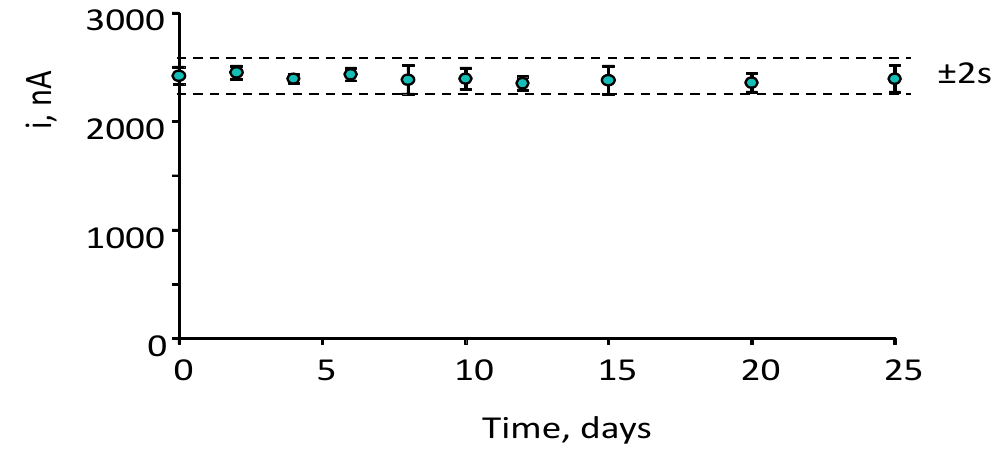
Figure 6. Control chart constructed to check the storage stability of anti–CCL5–Biotin–Neu–MBs conjugates upon storage at 8 ◦ C in Eppendorf tubes containing 25 µ L of PBS of pH 7. The central value was the average amperometric signal for 2 ng mL − 1 CCL5 provided by 10 different immunosensors prepared the day 0 of the study. Upper and lower limits of control were set as twice the standard deviation (2 s) of these measurements. Error bars were estimated as triple the standard deviation ( n = 3).